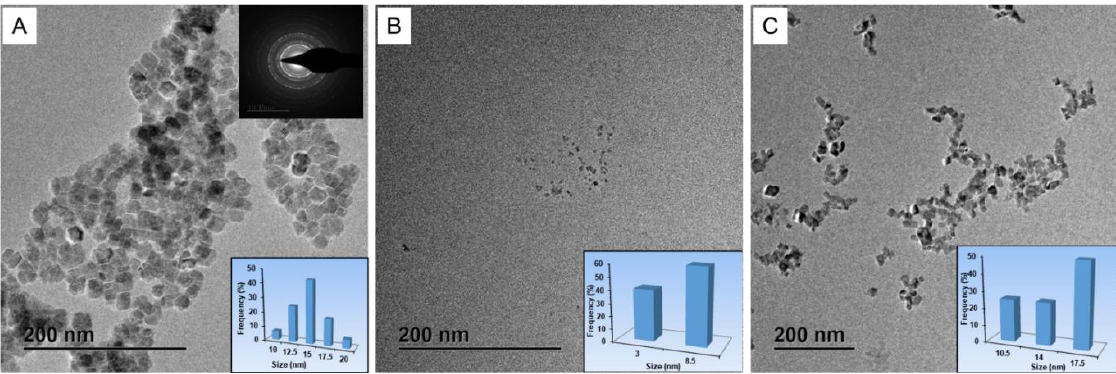
Figure 2. ( A ) TEM and SAED images of the prepared hydrophilic magnesium iron oxide@tetramethyl ammonium hydroxide nanoparticles (MgIONPs@TMAH), ( B ) RES NPs, and ( C ) BNF NPs.